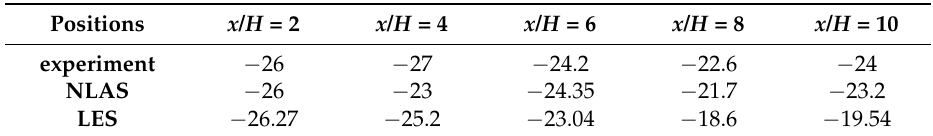
Table 2. Dominant frequency (Hz), where x is the distance from the probe to the step, and H is the height of the step. Positions x / H = 2 x / H = 4 x / H = 6 x / H = 8 x / H = 10 experiment 11.5 10.5 18 12 18 NLAS 14 7.1 13 13 9.1 LES 13.9 14.5 28.5 28.5